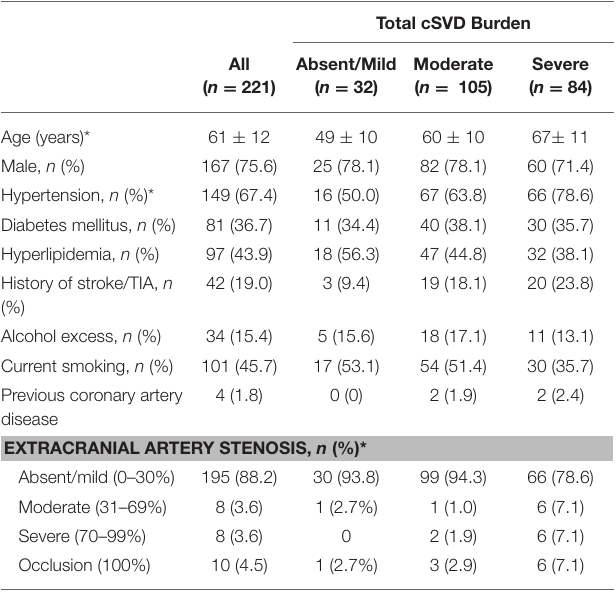
TABLE 1 | Clinical characteristics of included